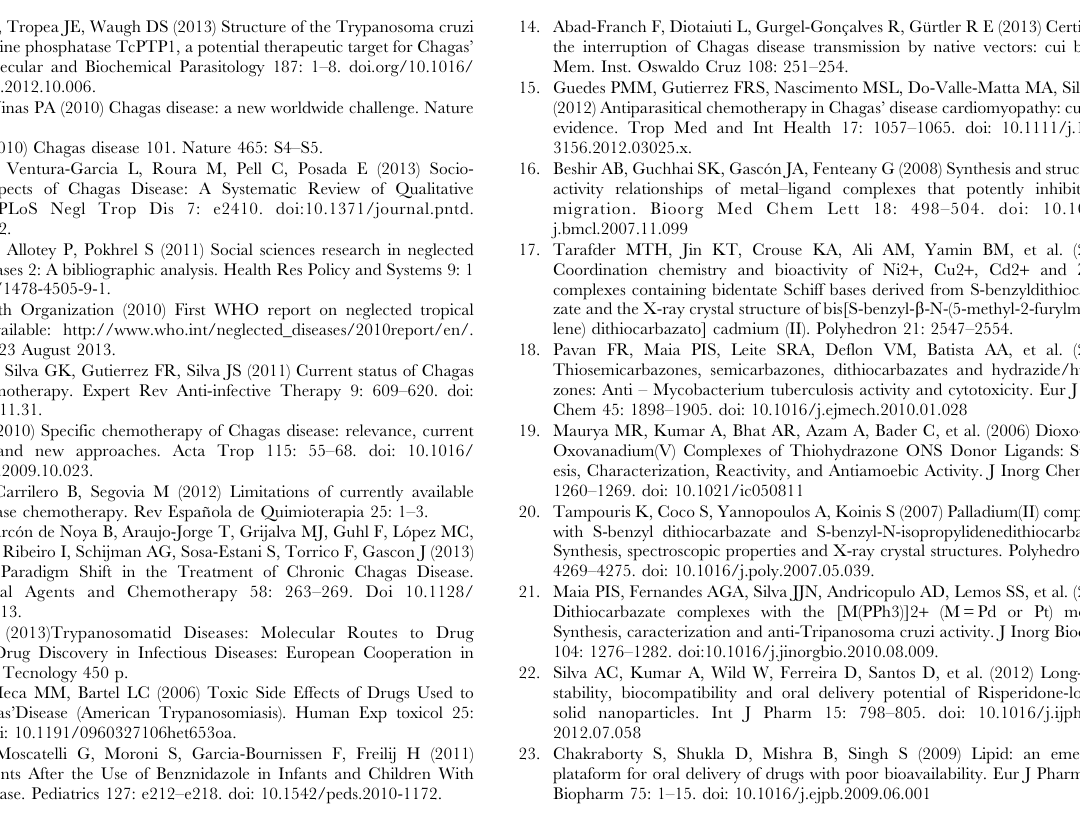
Figure S2 Parasitaemia of mice infected with T. cruzi and treated with free SLNs and PBS. Parasitaemia was monitored on days 7, 9, 11 and 13 after infection. Figure S3 Cardiac lesions of T. cruzi-infected animals after treatment with H2bdtc encapsulated in SLNs. The sections represent of heart tissues inflammatory process composed of various cell types (21 days after infection). Figure S4 Liver lesions of T. cruzi-infected animals after treatment with H 2 bdtc encapsulated in SLNs. The sections represent of liver tissues inflammatory process composed of various cell types (21 days after infection).